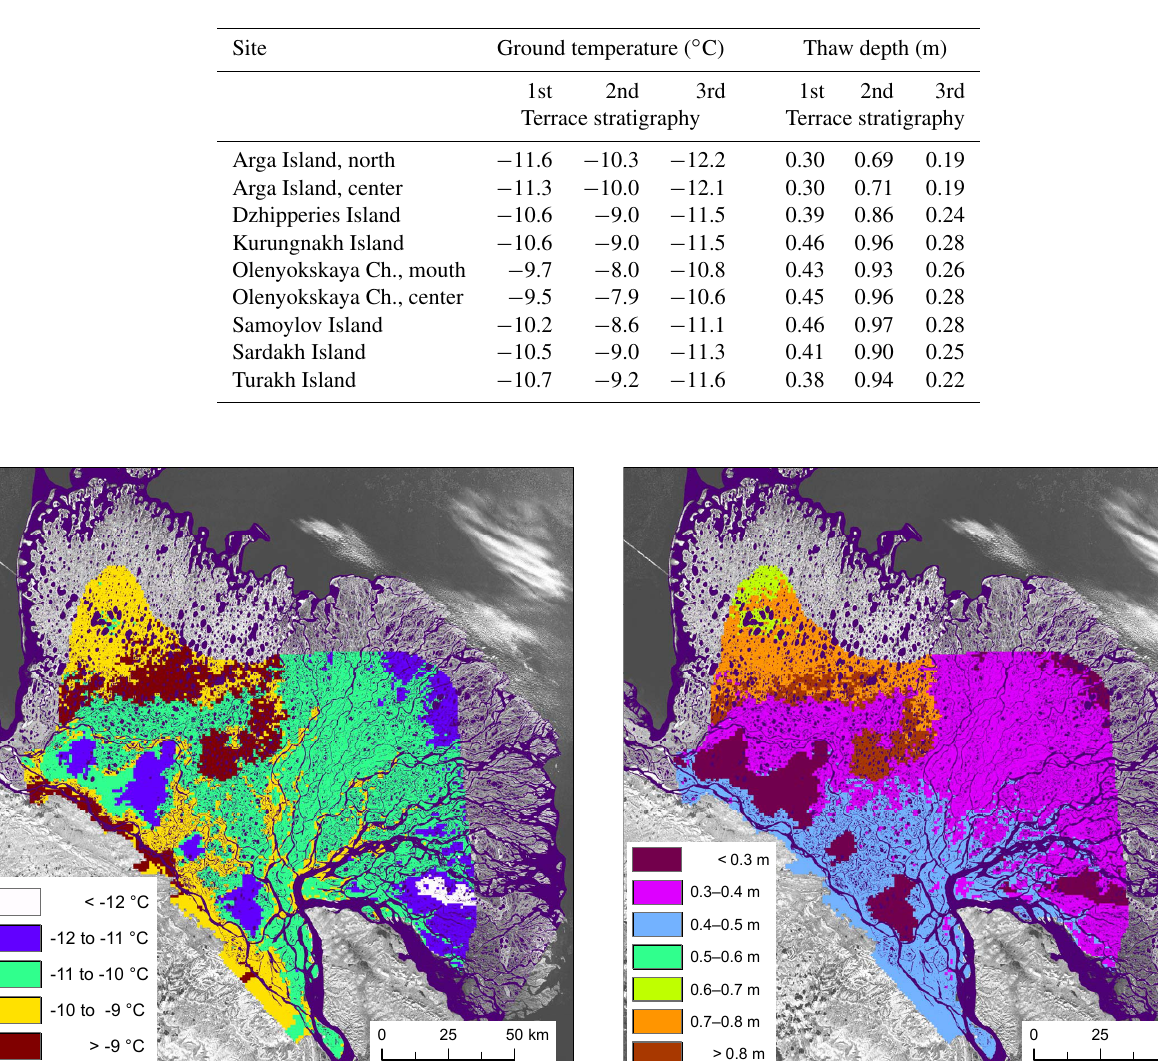
Table 3. Sensitivity of modeled average ground temperatures at 1m depth and average maximum thaw depth over the period 2004–2013. All simulations are with a snow density of 225kgm − 3 .